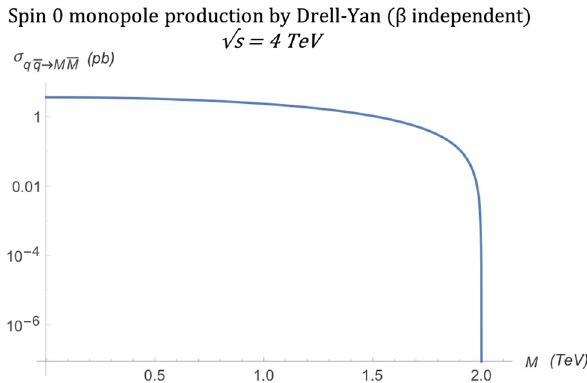
Fig. 7 Total cross section for the pair production of spin-0 monopoles via the DY process, in which β q = 1, as a function of the monopole √ s qq = 4 mass M at